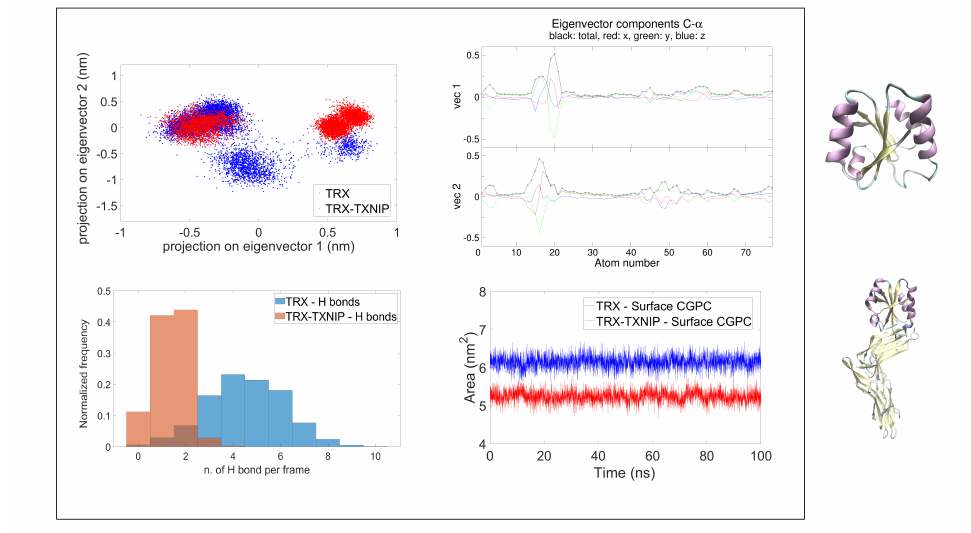
Figure 2. ( a ) PCA analysis on the C- α of TRX and TRX-TXNIP; ( b ) Eigenvector components analysis for the C- α atoms of TRX; ( c ) analysis of h-bonds between Cys 35 and solvent; ( d ) solvent accessible surface of the active site in TRX and in TRX-TXNIP. On the right of the figure, the TRX and TRX-TXNIP complex are shown in cartoon